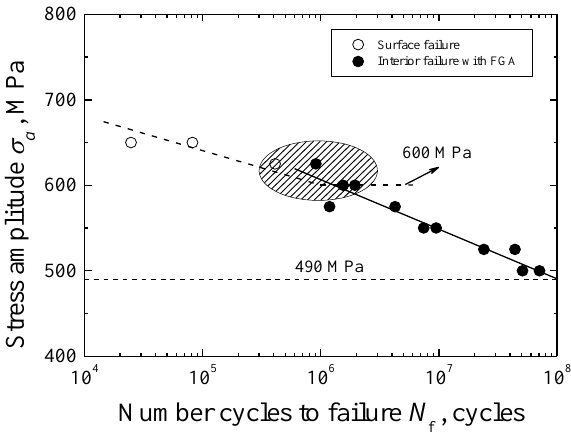
Figure 4. S - N curves of carburized 12Cr2Ni alloy steel.